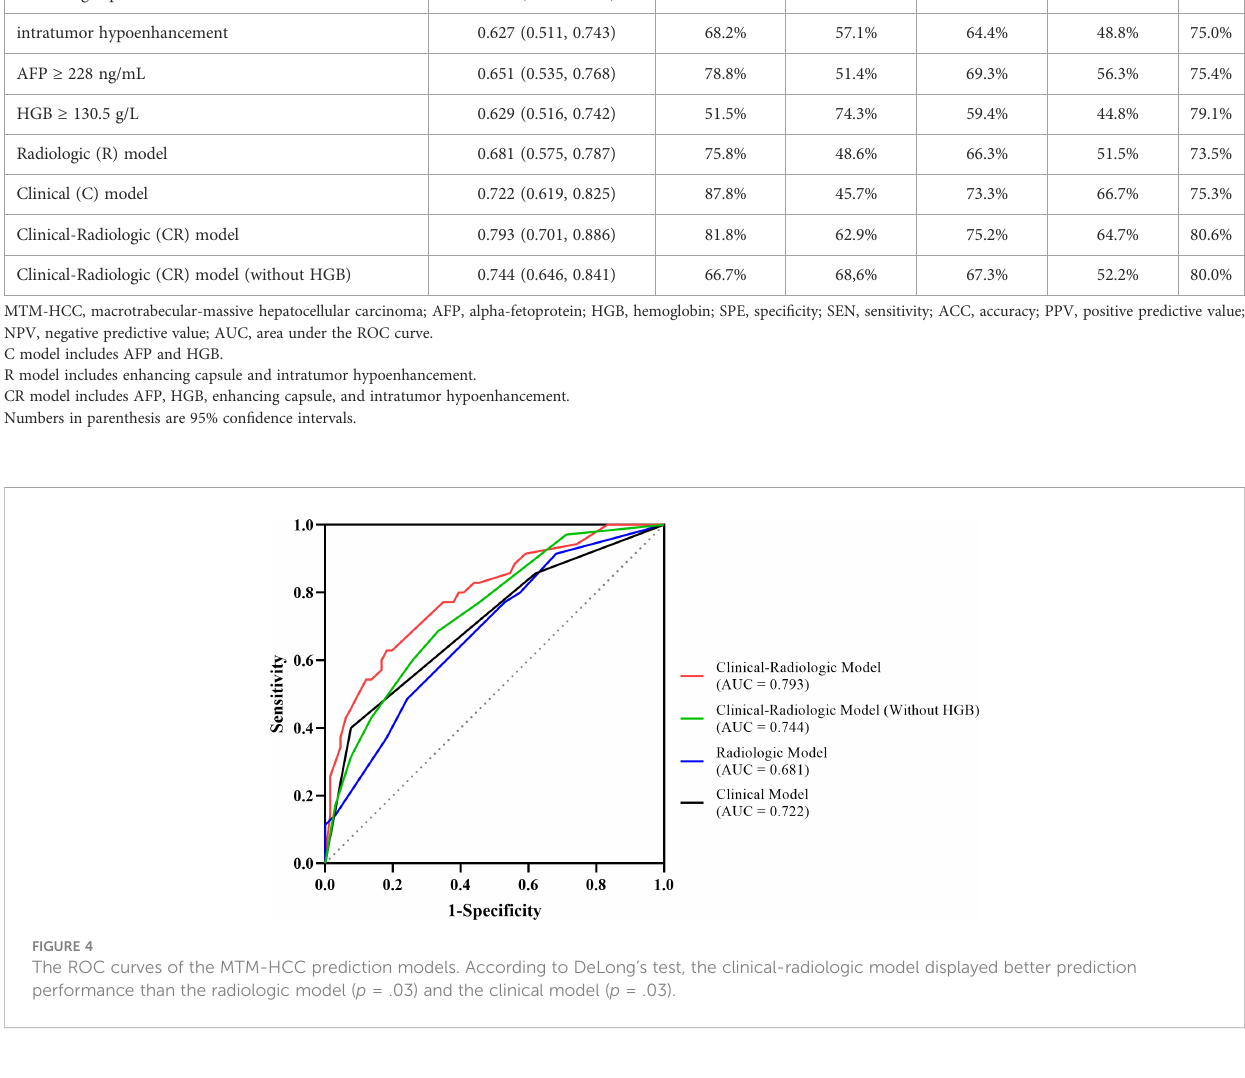
TABLE 6 Diagnosis performance of MTM-HCC predictive models in BCLC 0-A